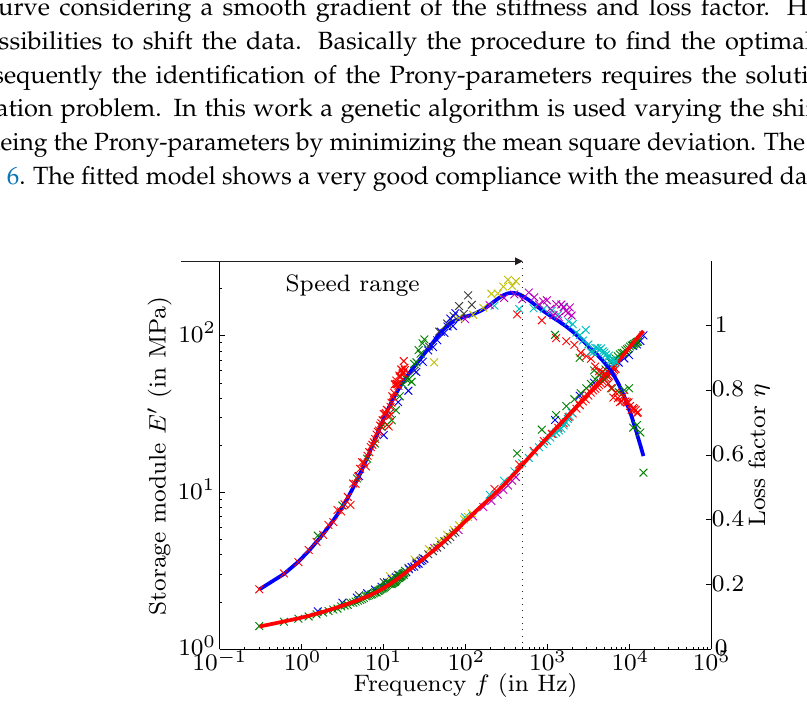
Figure 6. Fitted curves of the storage modulus (red) and the loss factor (blue) in comparison to the measured data ( × ) at a reference temperature of 25 ◦ C, whereby the different colors mark the various measurement